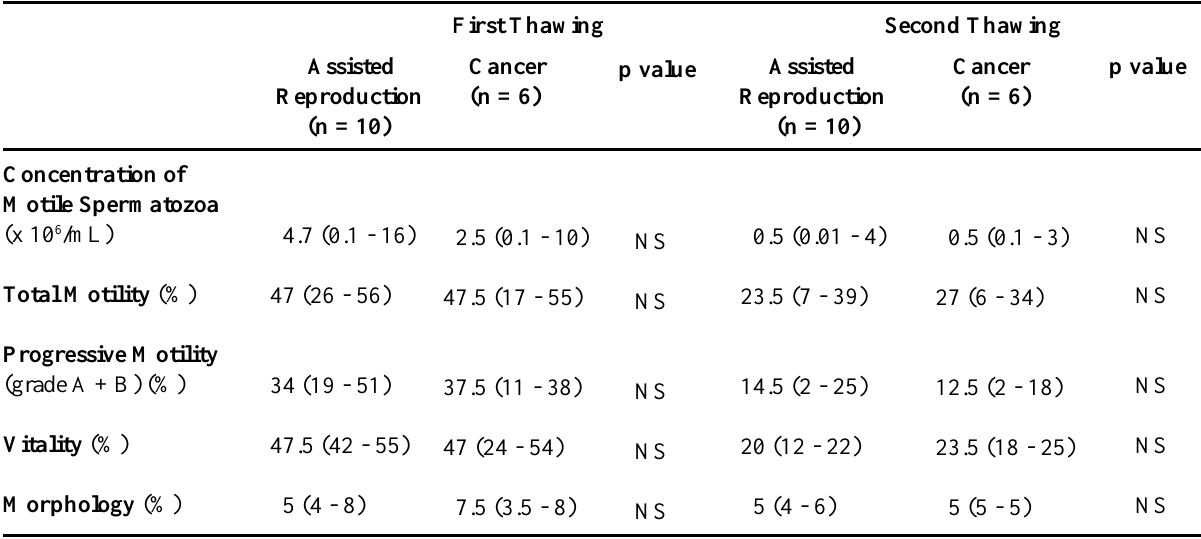
Table 2 – Spermatic parameters from 16 individuals divided into Assisted Reproduction and Cancer subgroups, after the first and the second thawing. The values are expressed as median and 25 and 75 percentiles.